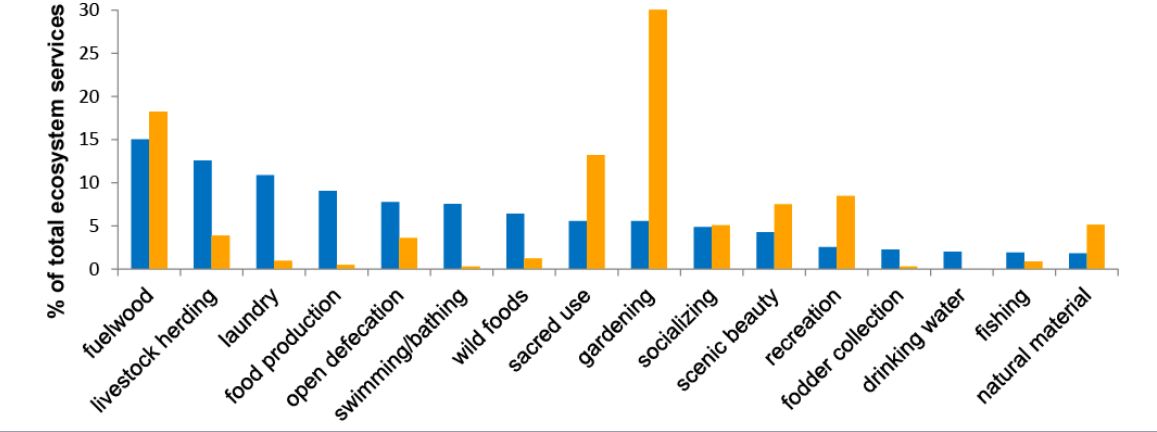
Fig. 6 . Relative importance of ecosystem services for both past conditions (around 1980, blue bars) and current conditions (2015, yellow